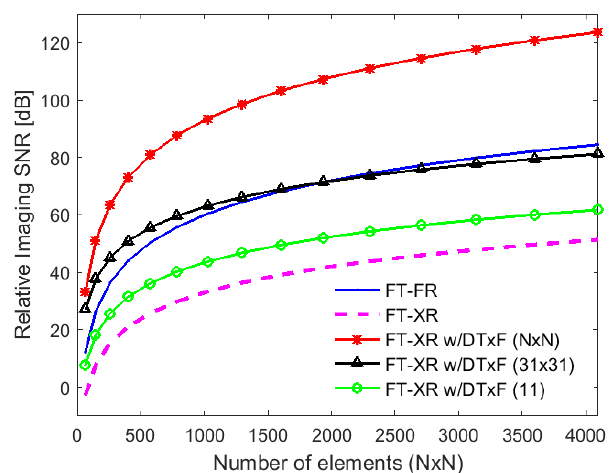
Figure 7. Relative imaging SNRs for unfocused FT-FR, FT-XR, and FT-XR with DTxF using N × N , 31 × 31, and 11 plane waves.